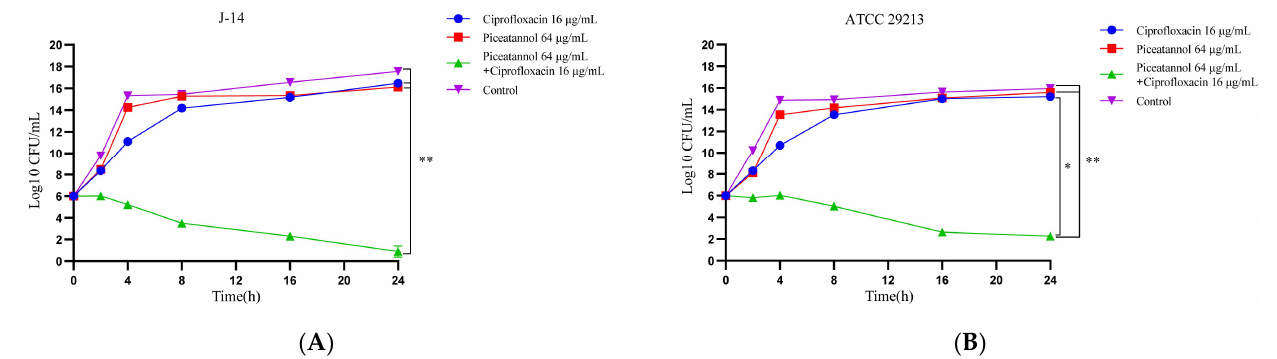
Figure 3. Time–kill curve of PIC and CIP against S. aureus strains. ( A ) J-14, ( B ) ATCC 29213. n = 3. Results from all experiments are presented as the mean ± SD of three replicates. * = p < 0.05, ** = p < 0.01.